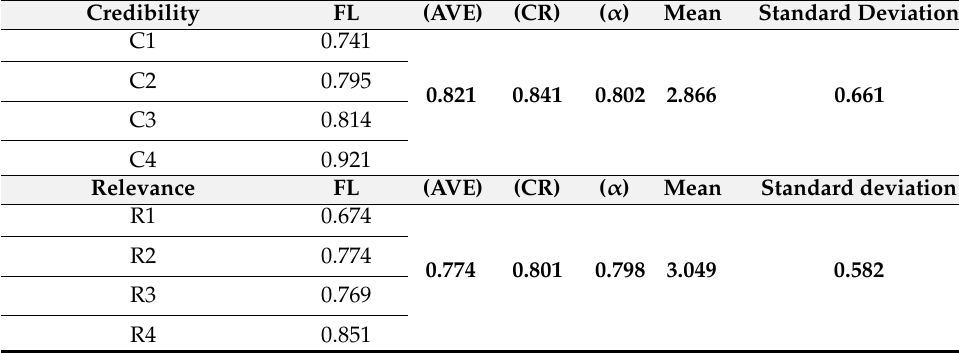
Table 3. Internal Consistency and Convergent